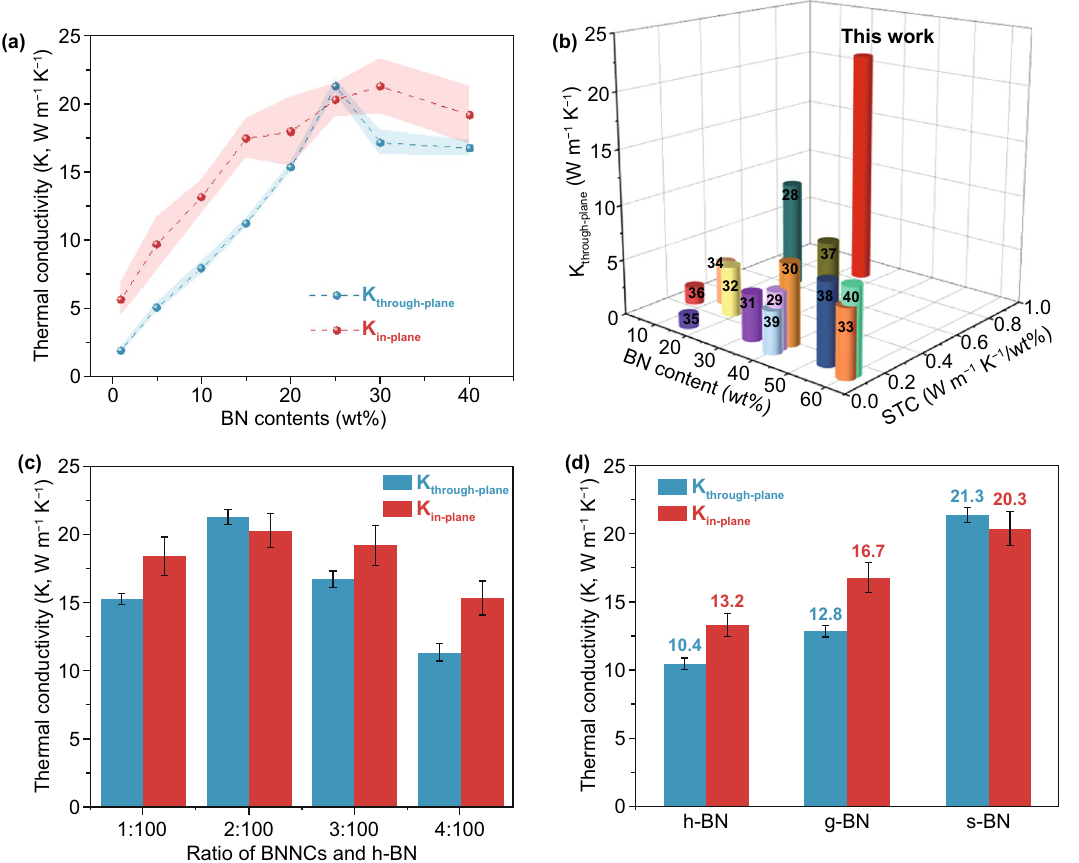
Fig. 3 Thermal performance of the polymer/s-BN composite film. a Thermal conductivity vs. BN content. b Comparison of the through-plane thermal conductivity and specific thermal conductivity (STC, = TC/filler loading (%)) of the polymer/s-BN composite film with those of differ- ent composite materials. The polymer/s-BN composite film presents more than twice the reported maximum for BN-based composites. Thermal conductivity with different ratios of BNNCs and h-BN c and different fillers